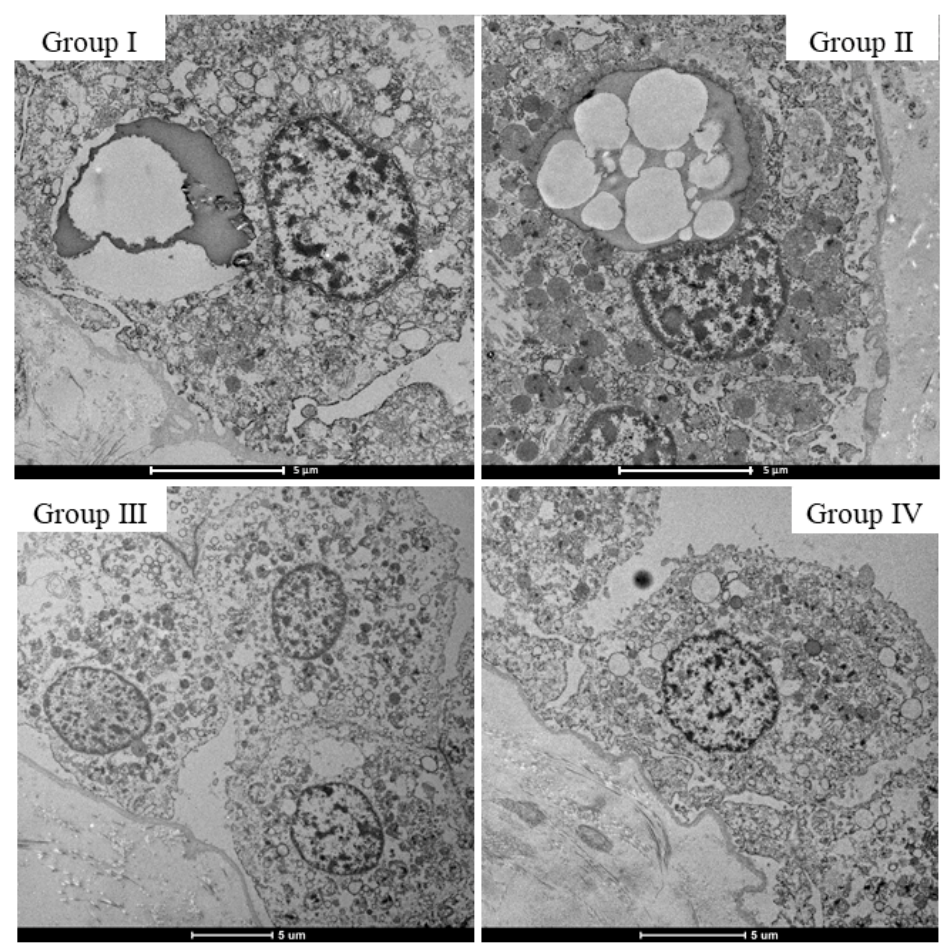
Figure 5. Morphological findings of choroid plexus epithelial cells using TEM. In Groups A and B, cytoplasmic vacuoles of the same size as the nuclei are observed; it seems that something has pooled in the cytoplasmic vacuole. Table 3. Caffeine concentrations ( µ g/mL) in vascular and choroid plexus epithelial cells at different time points after the addition of caffeine and